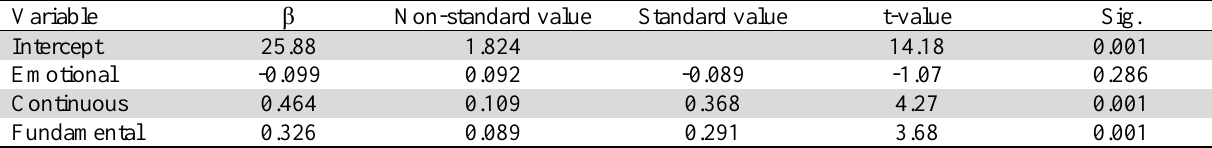
The results of regression analysis between components of organizational commitment and audit quality Variable